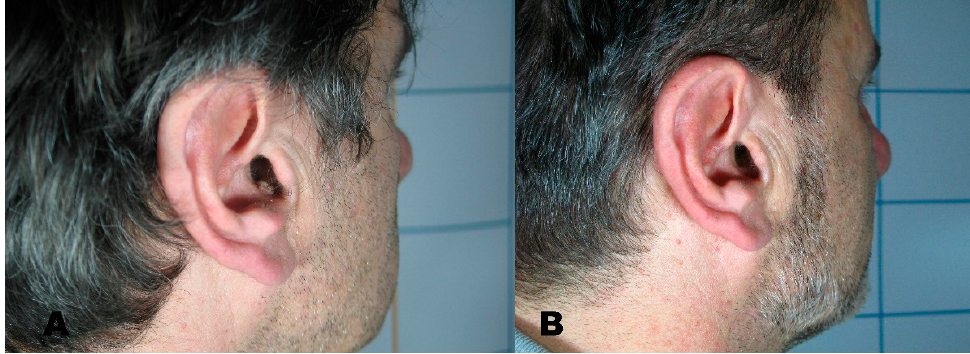
Figure 6. ( A ) Seborrheic keratosis before treatment. ( B ) Region after removal with Erbium laser.